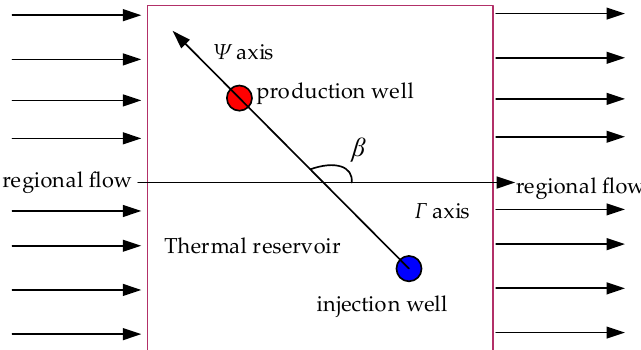
Figure 5. Double well layout of enhanced geothermal system under regional flow.